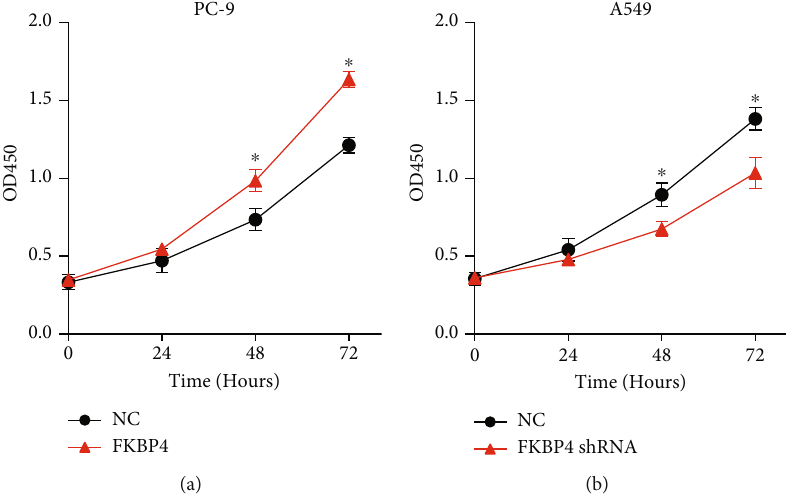
Figure 5: FKBP4 promotes the proliferation of NSCLC cells: cell proliferation after FKBP4 was overexpressed in PC-9 cells (a) or FKBP4 was silenced in A549 cells (b); N = 3 , ∗ P < 0 : 05